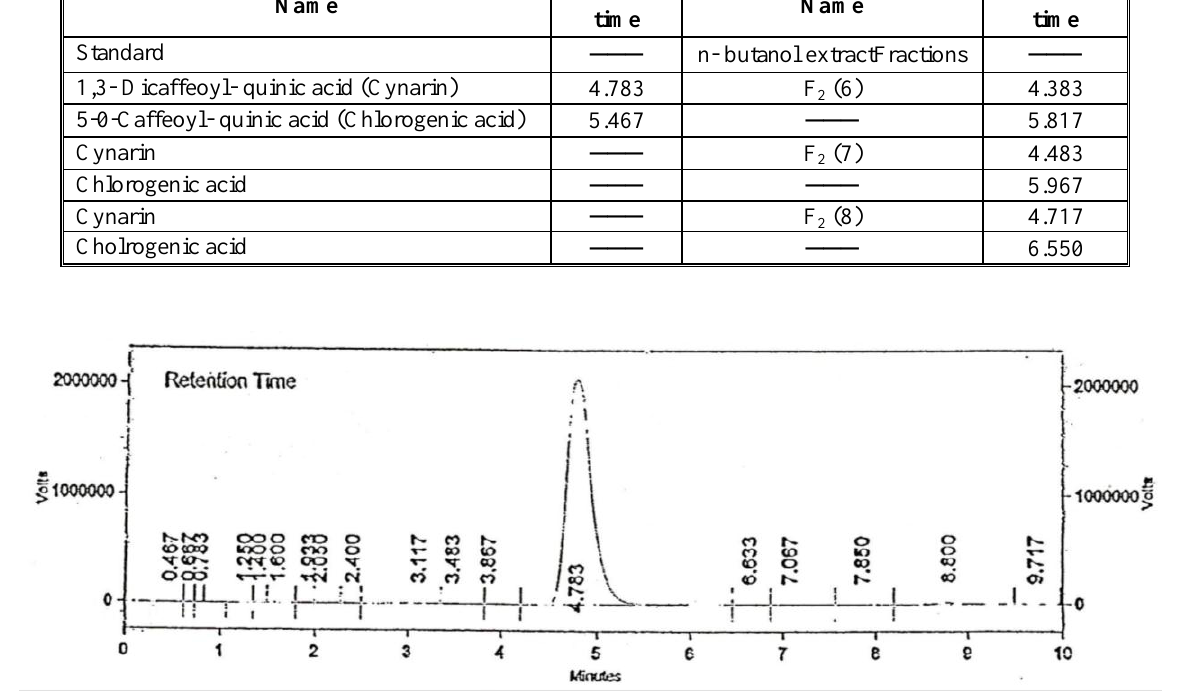
Figure 1 : HPLC analysis of Cynarin standard.